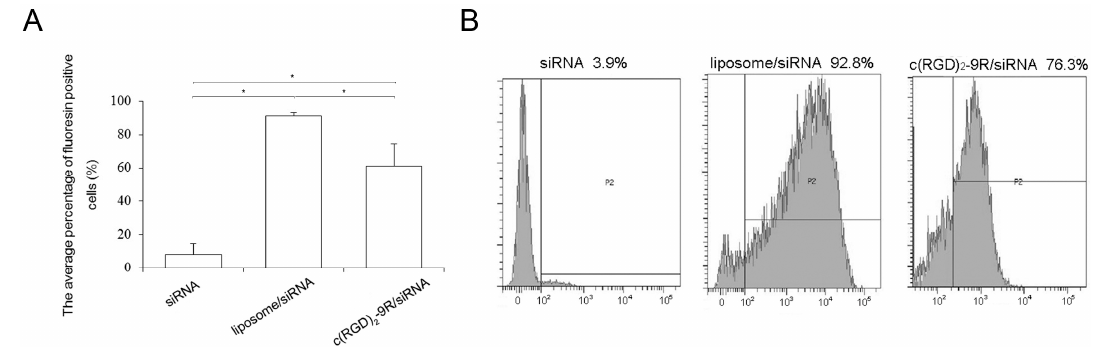
Figure 4. Flow cytometry analysis of cell transfection in vitro. HepG2 cells were transfected with FAM-siRNA alone, or FAM-siRNA mixed with liposome and c(RGD) 2 -9R at the concentration of 200 pM FAM-siRNA. The ( A ) average percentage and ( B ) representative plot of fluorescein-positive cells is indicated for each treatment. * represented p < 0.05.